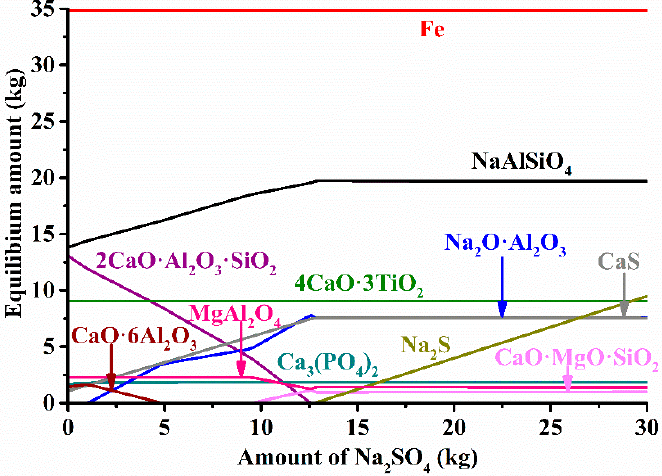
Figure 4. Effect of the Na 2 SO 4 addition on the equilibrium amounts of different phases at 1100 °C in the system that comprises 100% of the red mud sample B and 40% C.